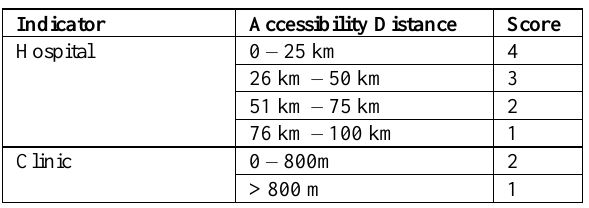
Table 4: The radius distance accessibility between residential housing and religion indicator